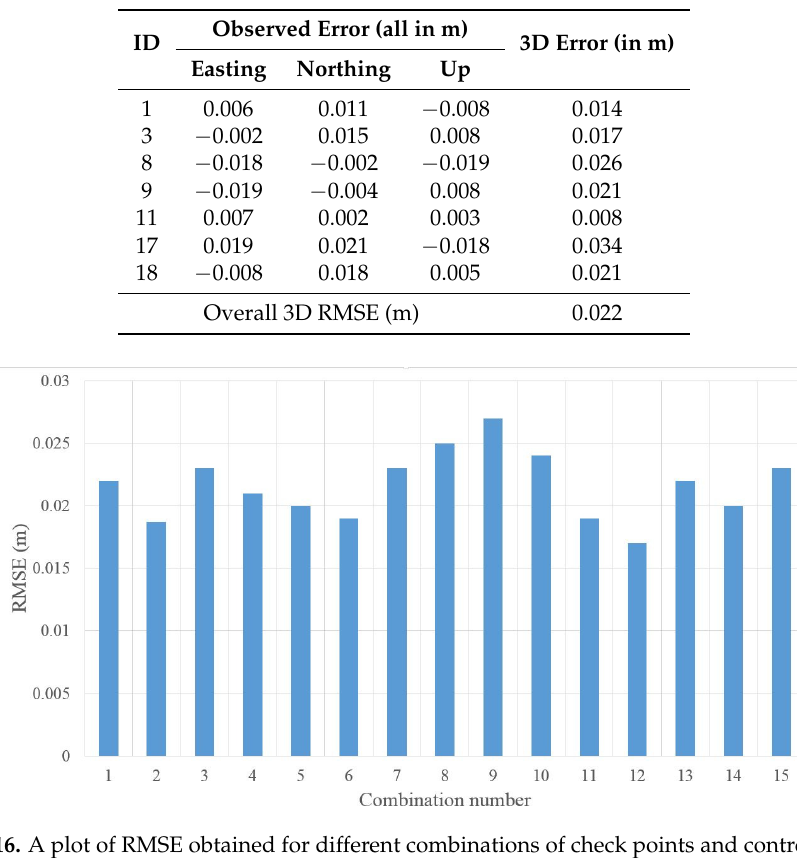
Table 3. Accuracy evaluation of the UAV trajectory estimated using Photogrammetry.